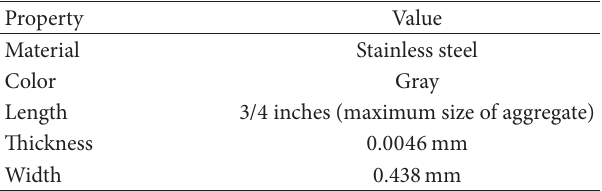
Table 1: Physical properties of the used asphalt cement.